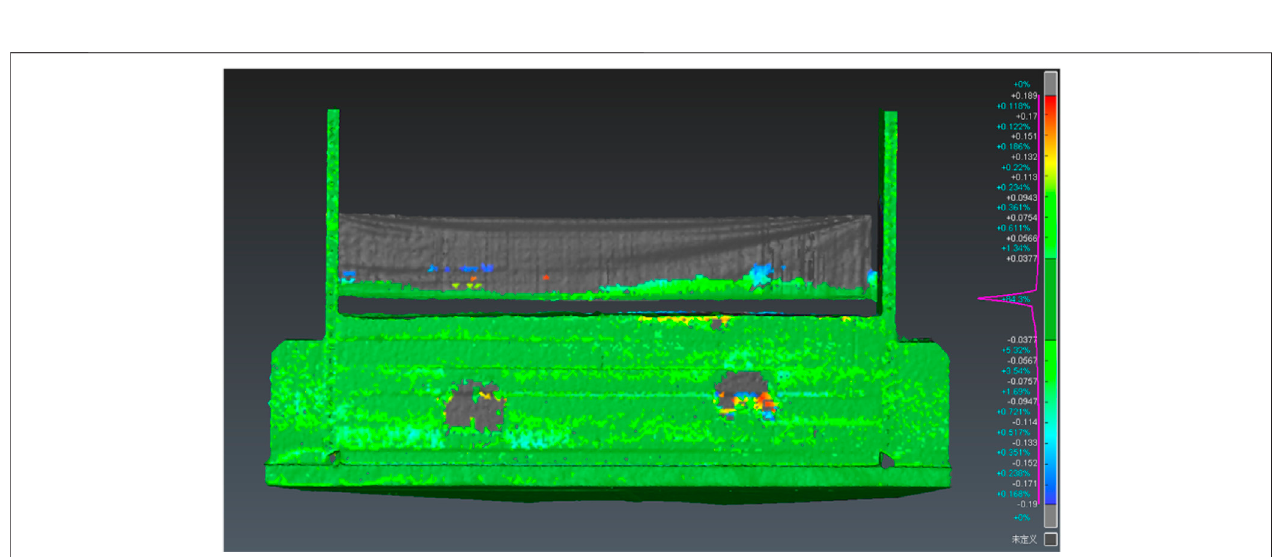
FIGURE 6 | Cloud chart of three-dimensional laser scanner monitoring convergence around the tunnel model.